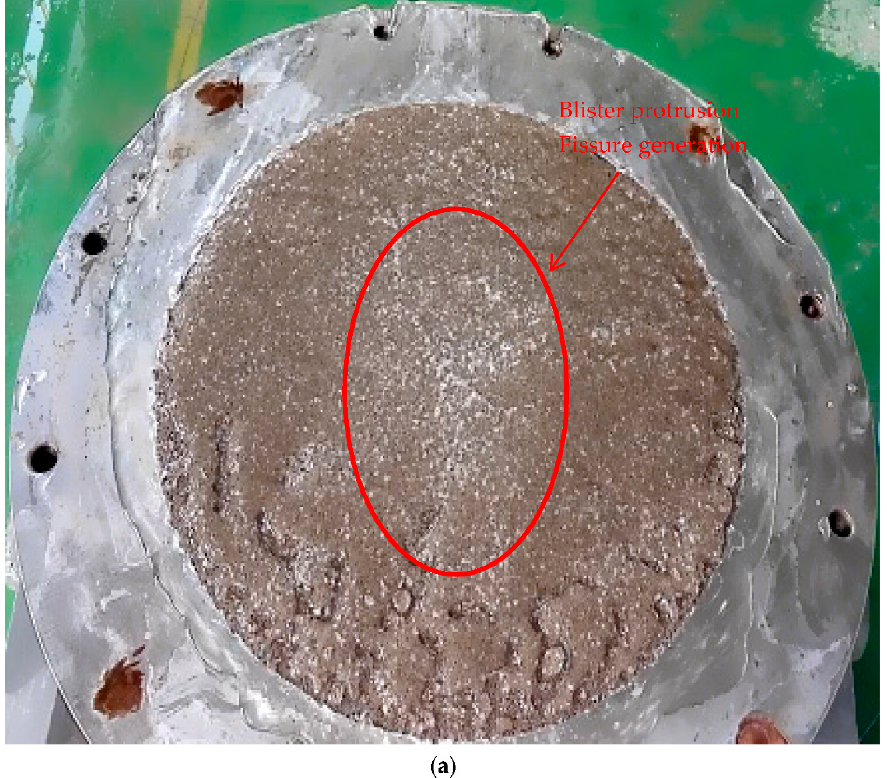
Figure 9. Water seepage stage at the bottom of arch. ( a ) The initial state. ( b ) Local water droplet attachment. ( c ) Instantaneous expansion of seepage zone. ( d ) The water seepage area is connected into one